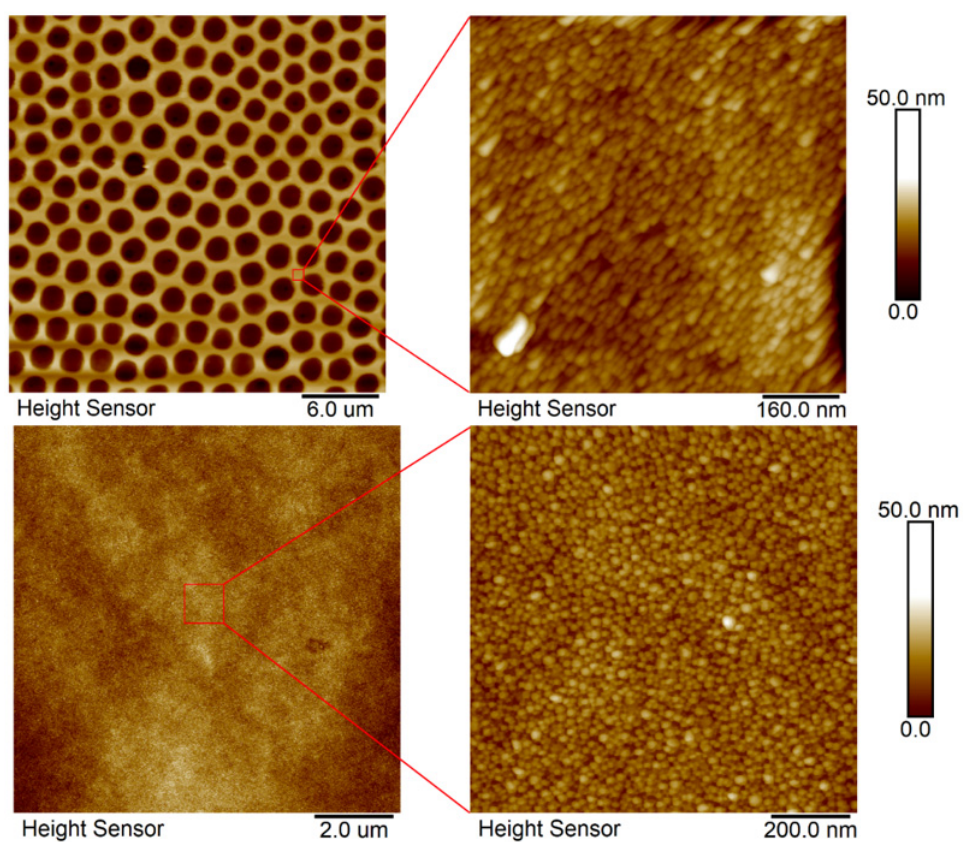
Figure 5. AFM scans of honeycomb pattern immobilized with Ag nanoparticles from the solution (upper line), 30 micron scan and 500 nm detail scans are presented. Morphology of polystyrene foil without the honeycomb pattern, which was exposed to the same conditions, is introduced in the bottom line of this Figure: 10 micron scans on the left-hand side.